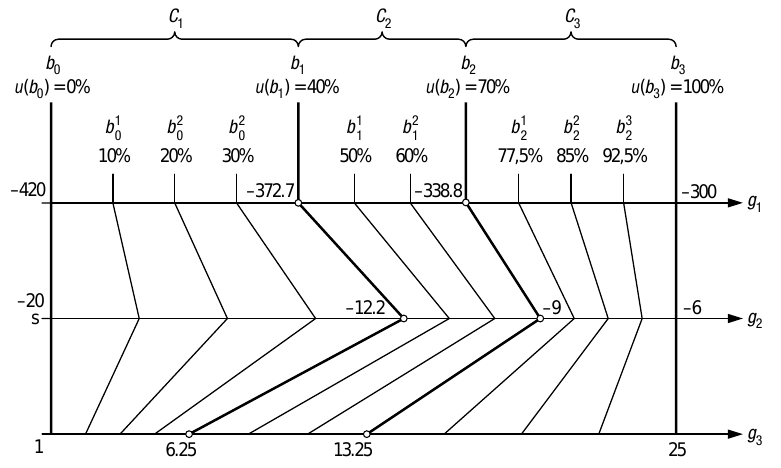
Fig. 5. Sub-categories and satisfaction